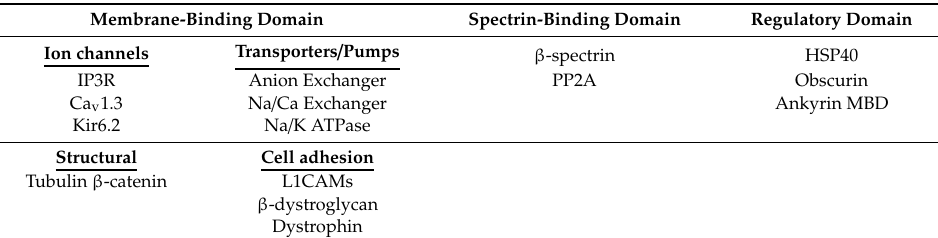
Figure 2. Representative diagram of ankyrin-B-binding partners to emphasize the importance of AnkB in the localization of ion channels, transporters, pumps, and structural proteins for proper cardiomyocyte function. Table 2. Ankyrin-B-binding partners in the